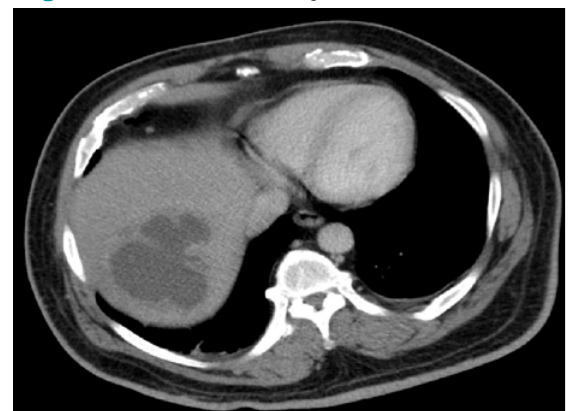
Figure 1. CT abdomen illustrating location of abscess